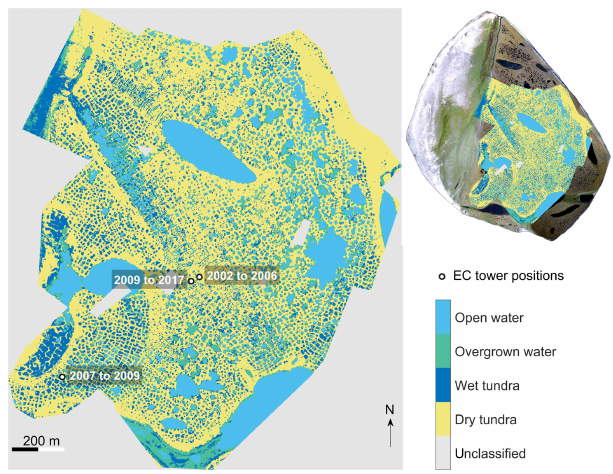
Figure 2. Eddy covariance (EC) tower positions on the river ter- race of Samoylov Island and surface class distribution according to Muster et al. (2012). Photographic image of the entire island (top right corner) from Boike et al.